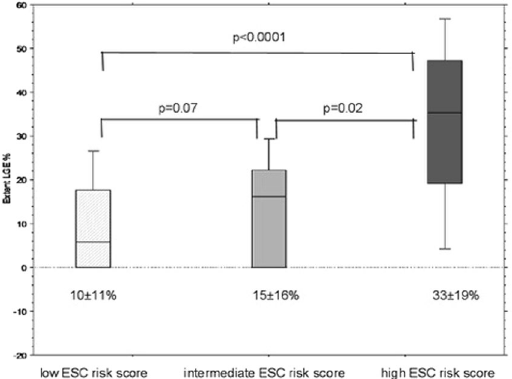
Figure 2. The box plots illustrate the extent LGE % in patients with a low ESC risk score (white crosshatched box plot), patients with intermediate ESC risk score (light gray box plot) and low ESC risk score (dark gray box plot). Extent LGE % is given as mean ± standard deviation below the box plots, the line in the box plots indicates the median value of the data. The p-values for the comparison of groups are also indicated. The figure also illustrates that patients with a high ESC risk score (defined as risk for SCD at 5 years ≥ 6%) reveal a significantly higher amount of LGE than those HCM patients with an intermediate (risk for SCD at 5 years ≥ 4– < 6%) or low ESC risk score (risk for SCD at 5 years < 4%). A risk of SCD at 5 years < 4% was considered as low, ≥ 4– < 6% as intermediate and as high risk. Abbreviations: HCM: hypertrophic cardiomyopathy, LGE: late gadolinium enhancement, SCD: sudden cardiac death.